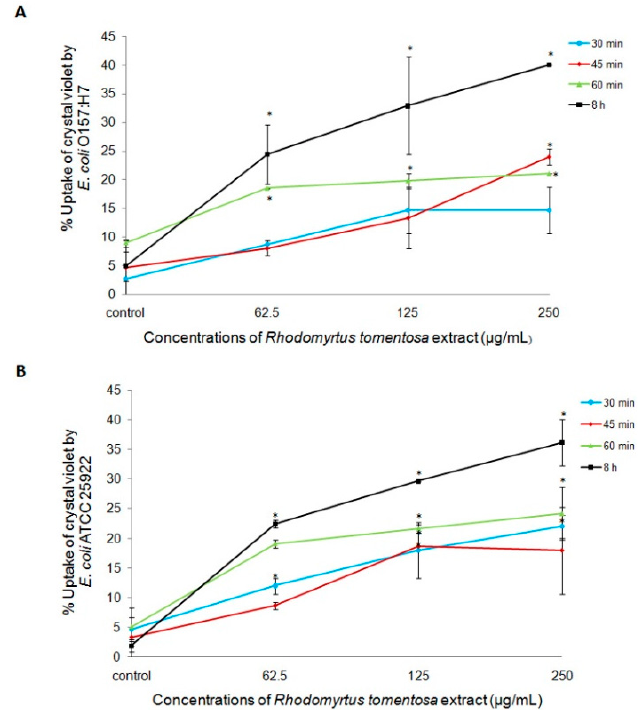
Figure 2. Effects of R. tomentosa extract on membrane permeability of Escherichia coli O157:H7 RIMD 05091078 ( A ) and E. coli ATCC 25922 ( B ) Crystal violet uptake by E. coli at 30, 45, 60 min, and 8 h after treated with the extract at 62.5, 125, and 250 µg/mL was determined. Dimethyl sulfoxide (0.5% v / v ) was used as the solvent control. Data are expressed as mean ± standard error from two independent experiments. Each measure was performed in triplicate. * Statistical significance at p < 0.05.